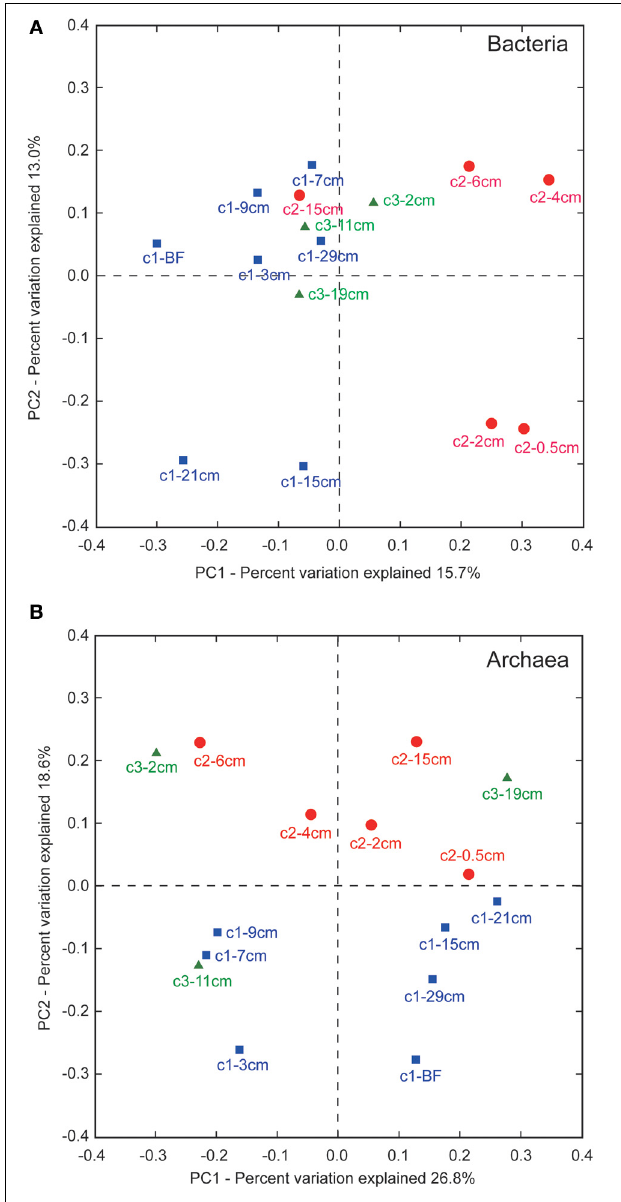
FIGURE 6 | Unweighted principle component analyses for (A) bacterial and (B) archaeal community assemblages. Labels for data points consist of core name (c1–c3) and average depth interval. “BF” stands for bubbling